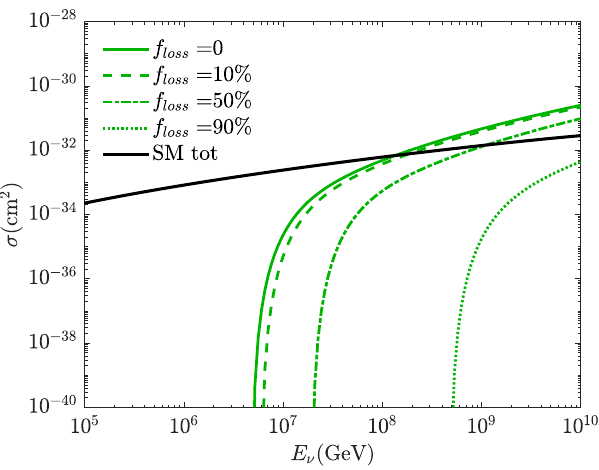
Figure 13 . The black hole production cross section from neutrino-nucleon interactions as a function of the incoming neutrino energy by including the initial energy loss. We assume M ? = 3 TeV and n = 6 extra dimensions. The solid, dashed, dash-dotted and dotted green lines correspond to 0, 10%, 50%, 90% energy loss respectively. The total Standard Model cross section is also shown by the black line.